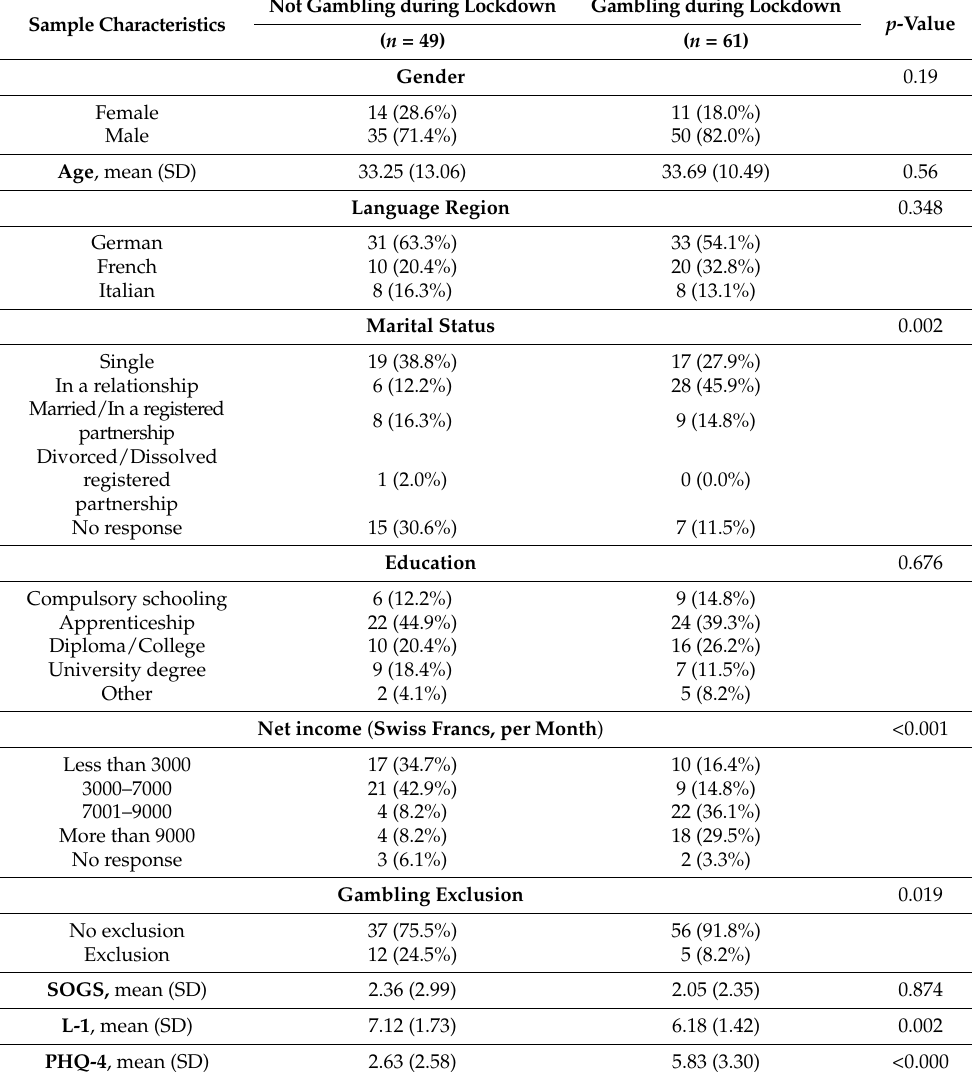
Table 4. Comparison between respondents who gambled and did not gamble during